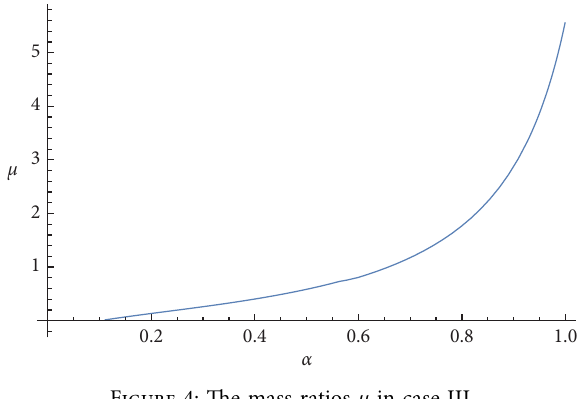
Figure 4: Te mass ratios μ in case